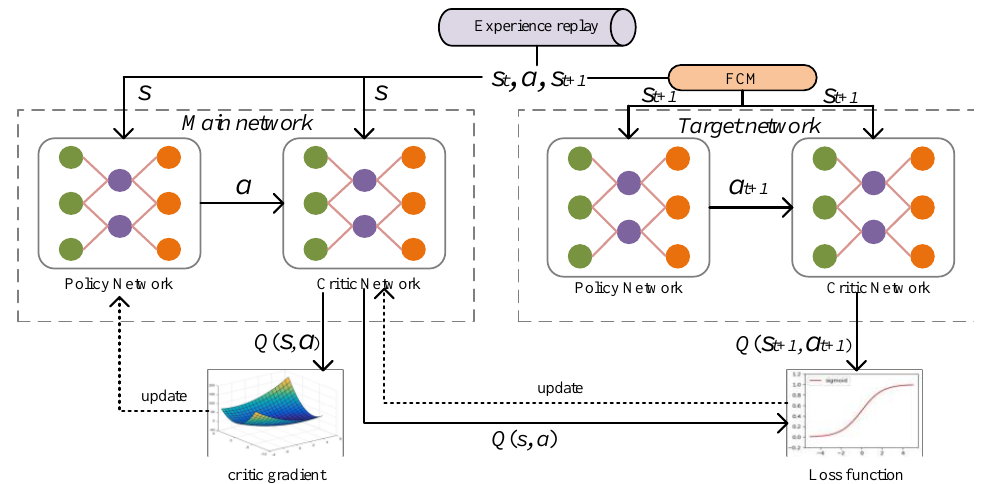
Figure 1. The training process of the DQN network